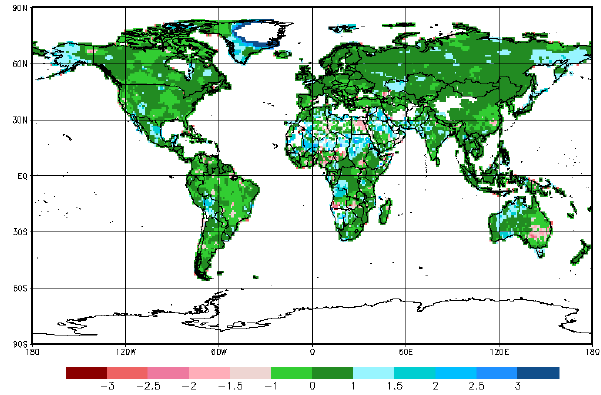
Figure 12. The GPCC-DI with 6-month accumulation interval for January 2014. The color scale is the same as in Fig. 3. Table 1. Interpretation of GPCC-DI values, adapted from Lloyd- Hughes and Saunders